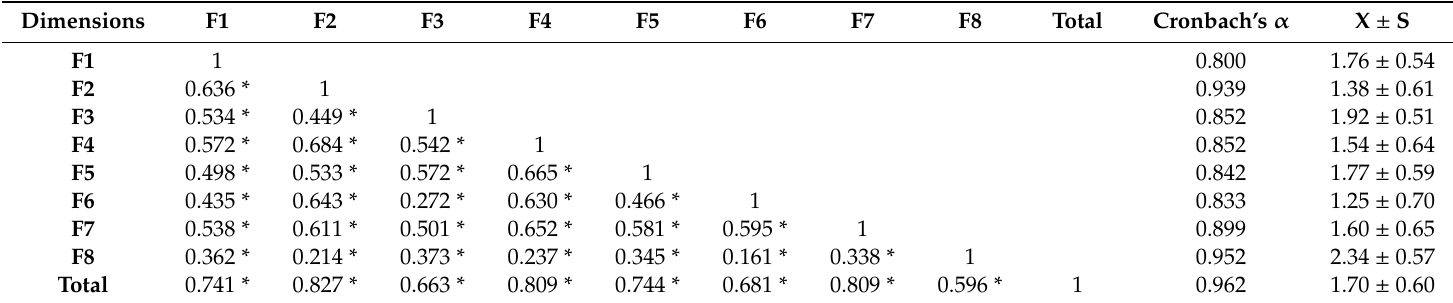
Table 4. Correlation analysis and the internal consistency reliability of the